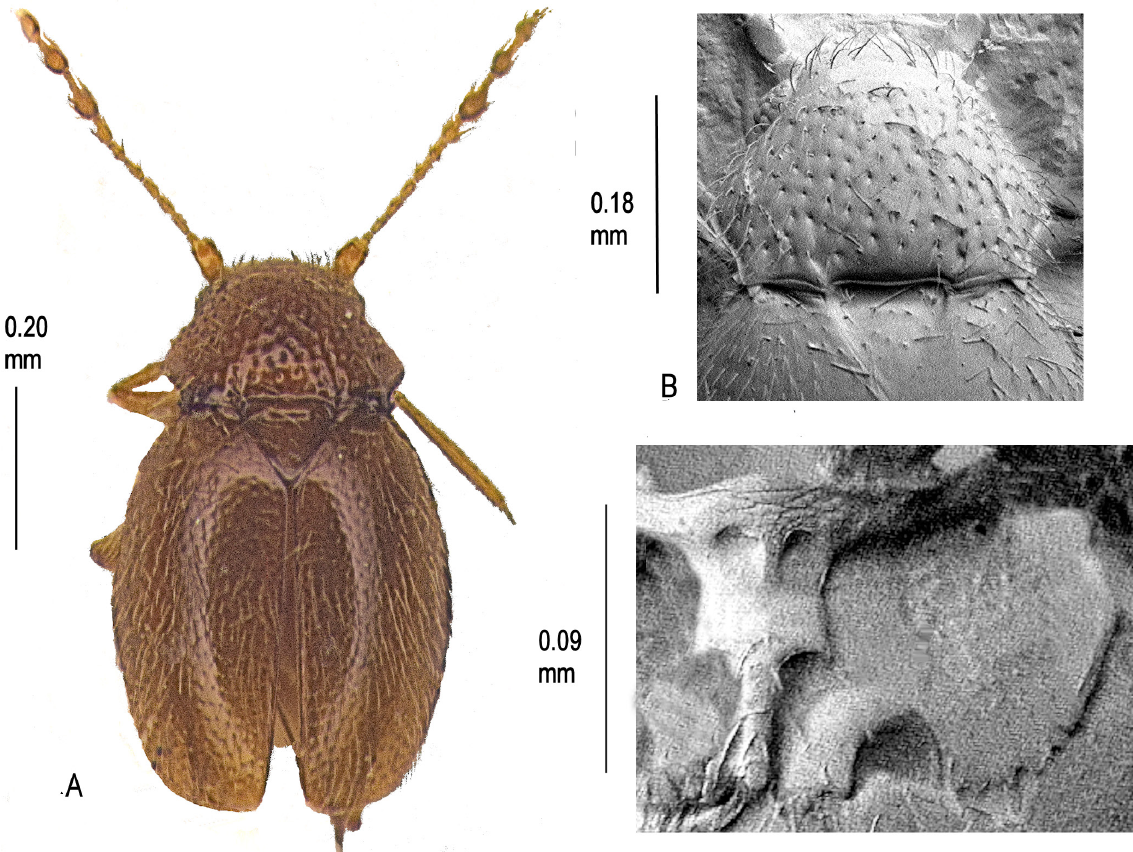
Fig. 56. Cissidium mindanao sp. nov. A . Habitus. B . Pronotum, × 430. C . Mesoventrite showing median process of collar, mid-keel, keel and lateral margin, ×